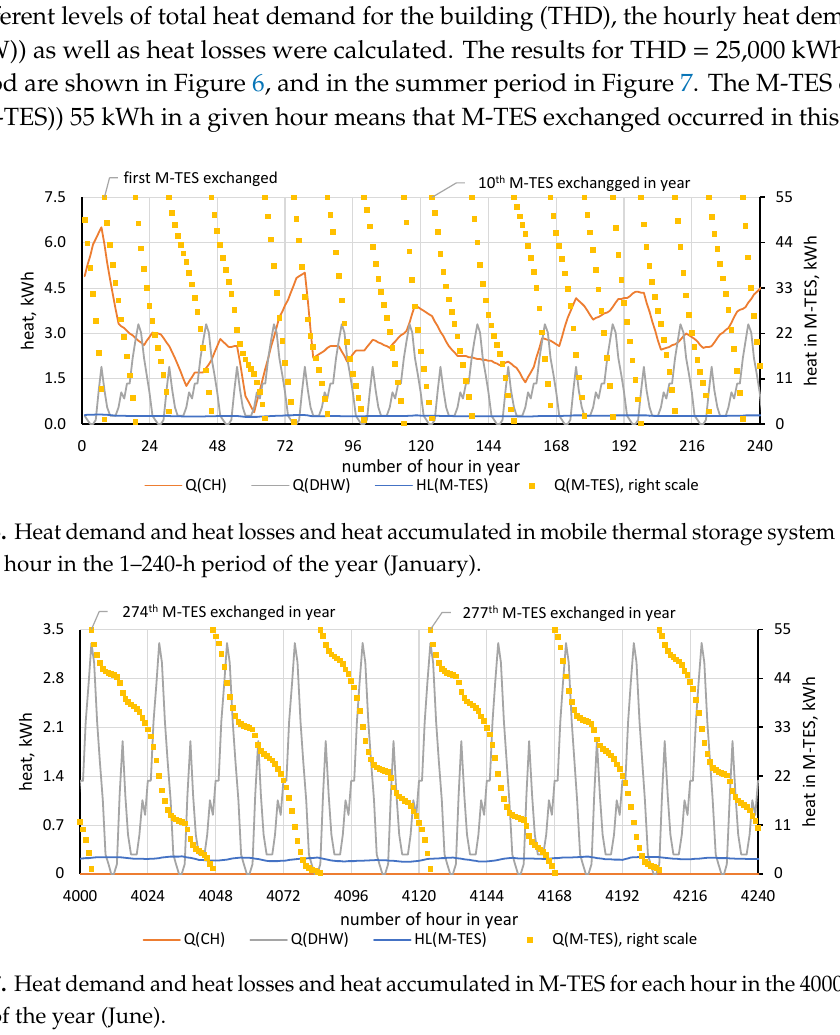
Figure 8. Number of M-TES exchanges (M-TES.EX) during each month of the year for different value of total heat demand (THD): 5000, 15,000 and 25,000 kWh/year. For THD = 5000 kWh/year, the maximum number of exchanges per month is 19, for THD = 15,000 it is 48, and for 25,000 it amounts to 78 (December). A feasibility analysis of the M-TES replacement in the context of various types of restrictions was carried out. The results presented below show the example, based on the calculations for the last value (78). The first of the analyzed restrictions is the M-TES charging and discharging rate: 78 exchanges mean almost three exchanges per day—the average charging power is approx. 7 kW. The maximum estimated charging power of 14 kW is realized with a flow temperature of 86°C and a return temperature of 72°C. Under these conditions, the flow rate would be 0.25 dm 3 /s. For THD = 25,000, the simulation received nine days with four M- TES exchanges per day (this means the average charging power of 9 kW). A similar situation is found for the M-TES discharging process. Further research includes work related to the irregularity of the M-TES maximum charging/discharging rate. In total, the number of exchanges in the year M-TES (M-TES.EX) is 147, 337 and 533, respectively. The number of exchanges needed to ensure the demand of THD = 15,000 kWh/year is 2.3 times higher than for THD = 5000 kWh/year, while the ratio of demand is three times higher. The reason for this phenomenon is the practically constant level of heat losses (HL (M-TES)) independent of the THD value in the adopted range.